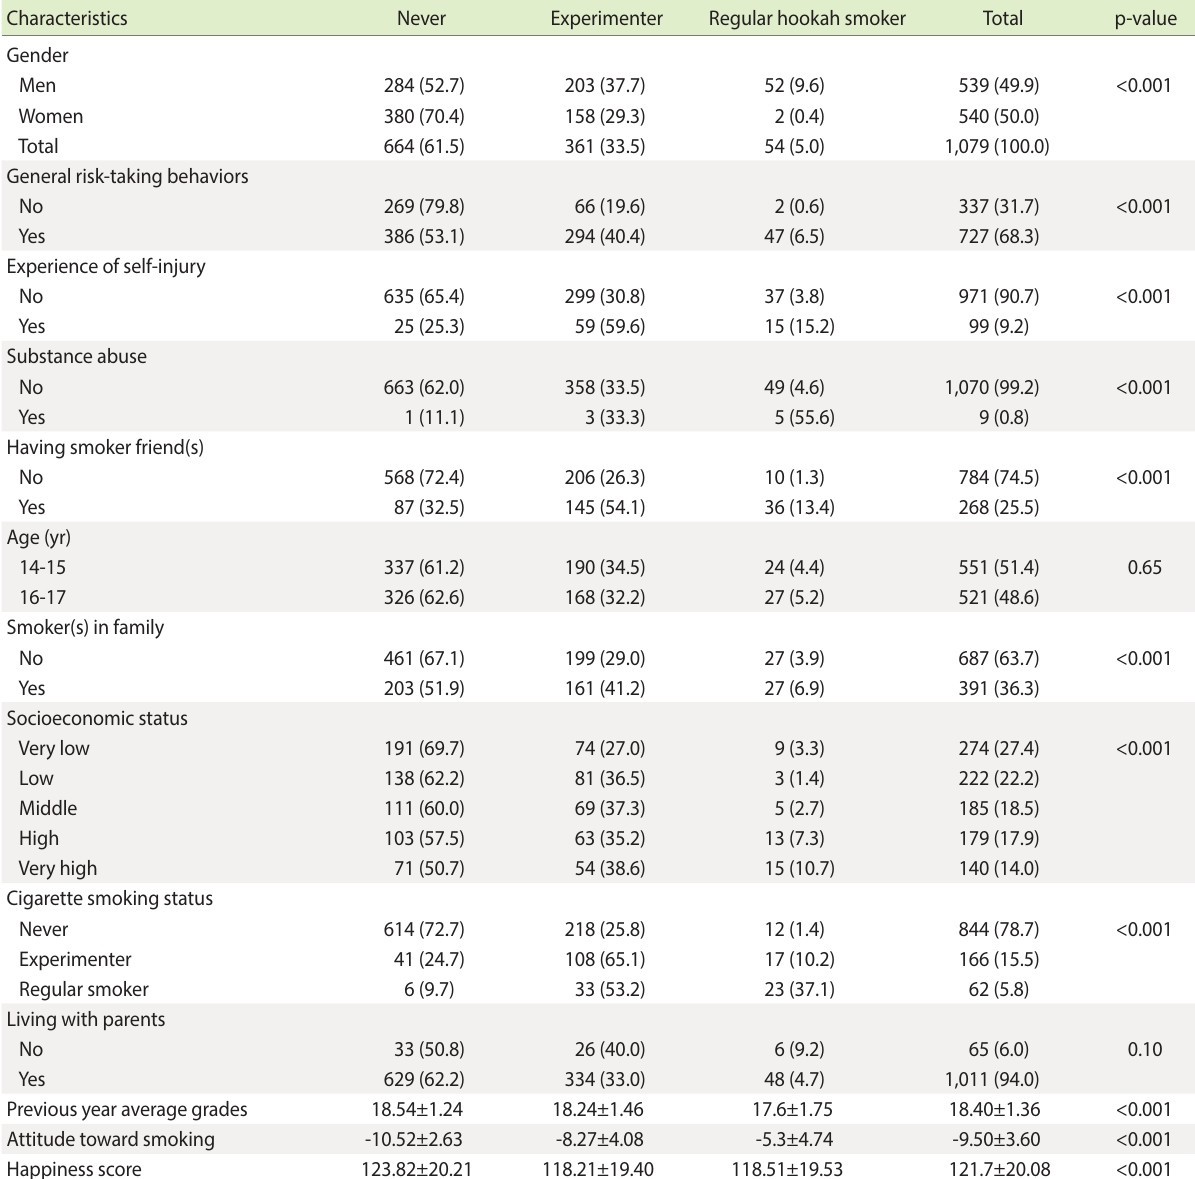
Table 2. Demographic and other characteristics of the students according to hookah smoking status